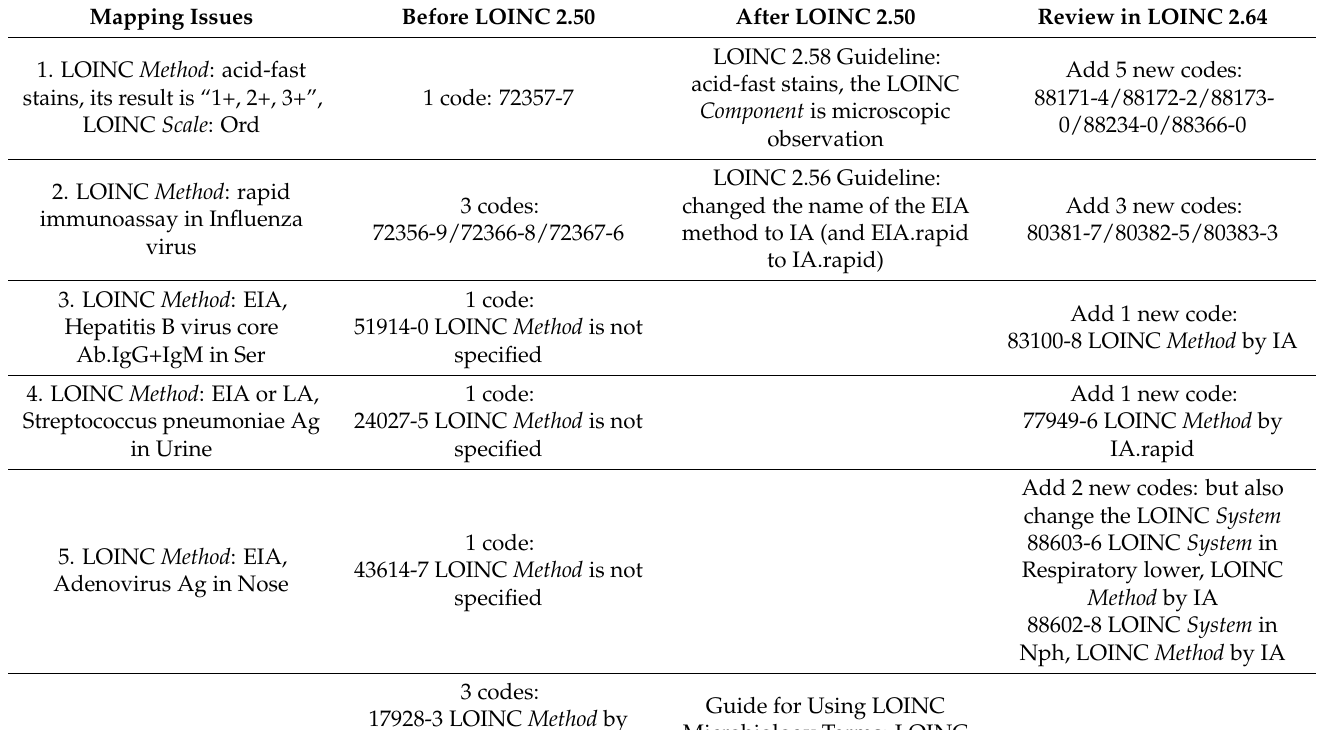
Table 5. Compression of mapping performance before and after